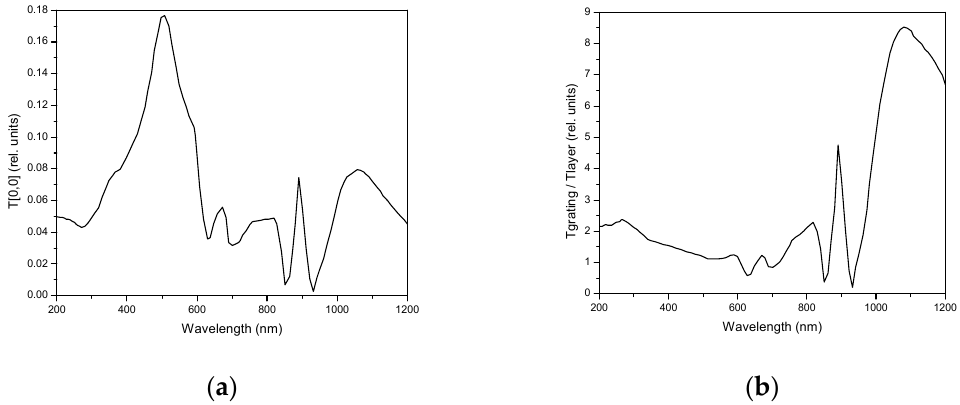
Figure 3. Calculated spectral transmittance of the 2D regular rectangular plasmonic holes array (see text for parameters) referred to BK-7 glass slide ( a ) and continuous Au/Cr/Bk-7 slab ( b ); FMM simulation technique applied.